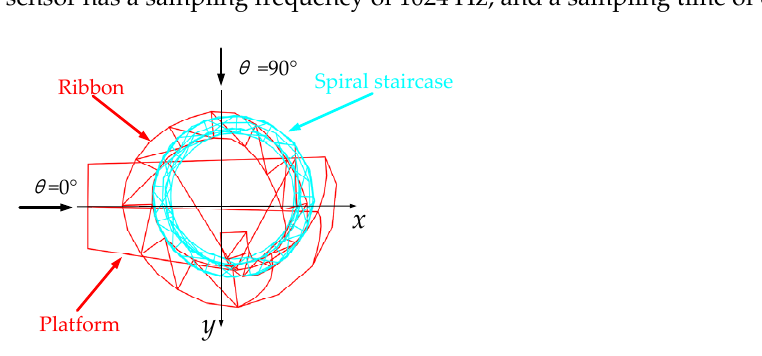
( b ) Figure 2. Simulated wind flow in the wind tunnel: ( a ) Mean wind speed and turbulence intensity profiles; ( b ) Wind power spectrum profiles. 2.3. Layout of Measuring Points and Test Conditions It is necessary to use the atmospheric boundary layer model wind tunnel test to obtain the wind-induced response time history value of the landscape tower for calculating β d and β i ( z ) of the landscape tower test. The acceleration sensor 4507-B-006 produced by B&K company in Denmark and the high-precision laser displacement sensor HL-C235BE produced by Panasonic industrial equipment company in Japan were used to measure the acceleration response and displacement response of the LT, respectively. To explore the effect of the θ and v change on β d of the LT, θ is characterized as 0° when it is in the positive direction along the x -axis and 90° in the positive direction along the y -axis. The definition of θ is depicted in Figure 3. For the LT with asymmetric cross-section, its model needs to be rotated once to fully consider the influence of θ .